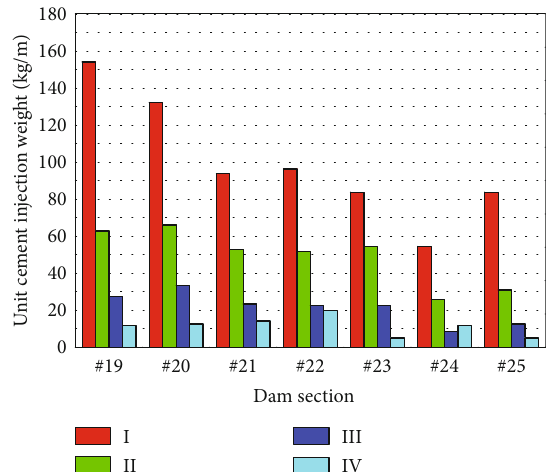
Figure 19: #19 ~ #25 dam section consolidation grouting of hole: unit cement injection weight.